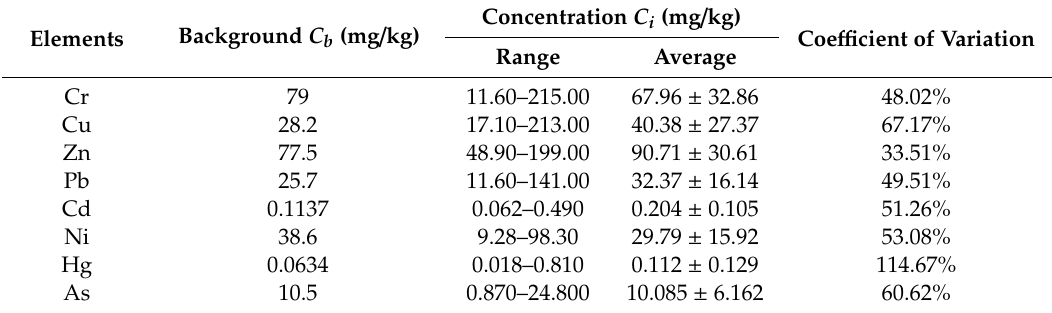
Table 6. Concentration statistics of heavy metals in